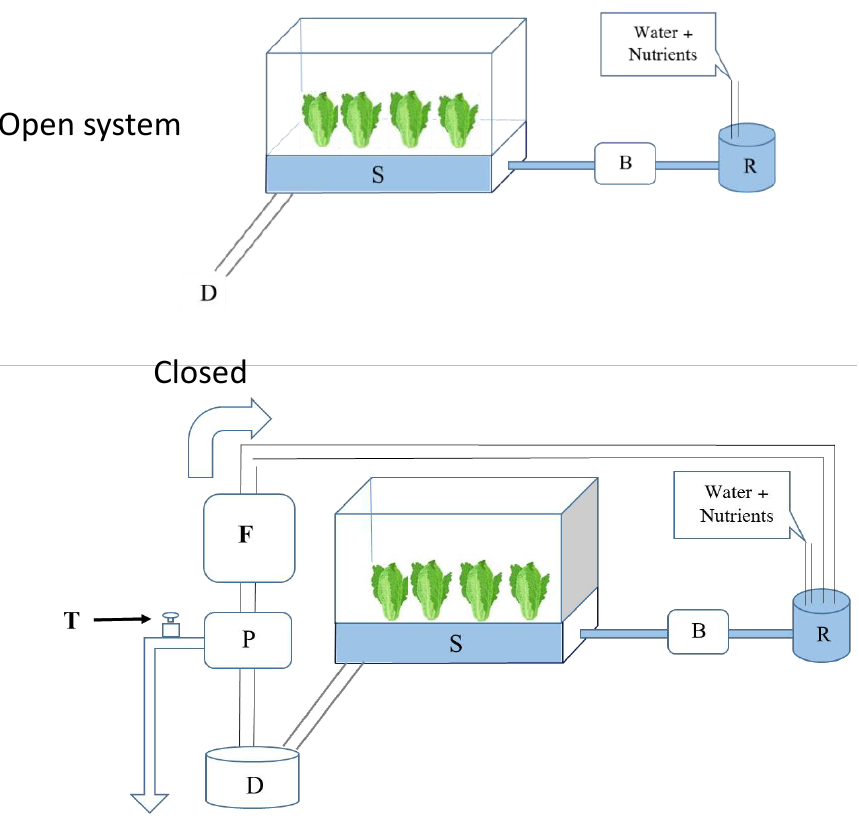
Figure 1. Schematic presentation of open and closed hydroponic irrigation system. R, reservoir; B, booster pump; S, substrate/solution; D, drainage; P, pump; T, tap; F, filter.